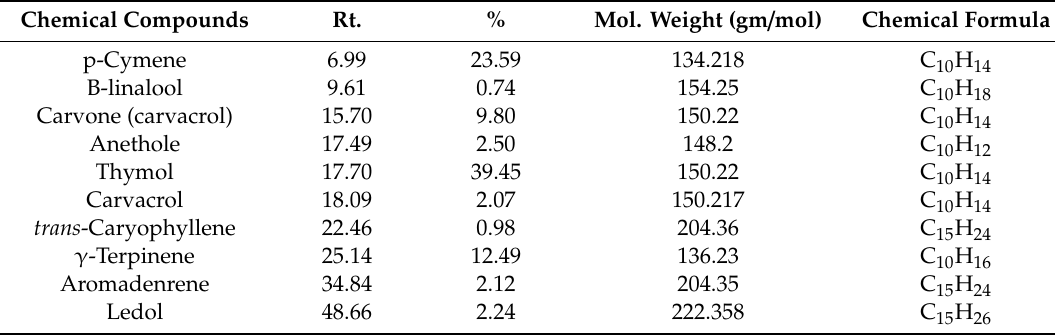
Table 2. Major chemical compounds of hydrodistilled thyme essential oil (TEO) as detected by gas chromatography–mass spectrophotometer